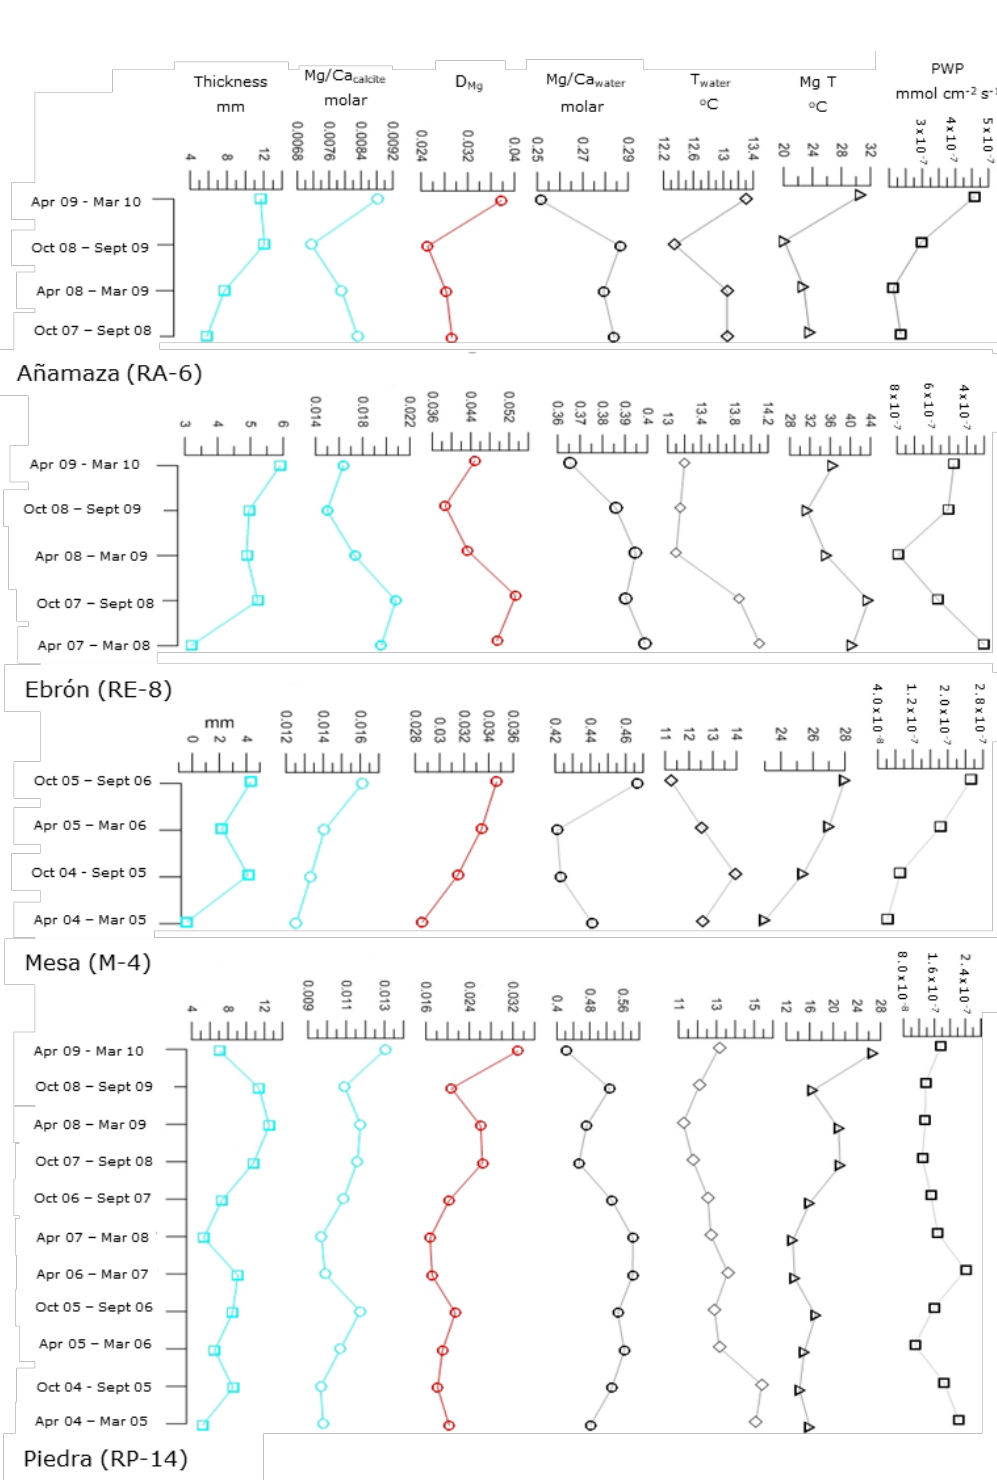
Figure 6. Temporal evolution of season-free interannual evolutions of some parameters during examined sampling periods in water and stromatolites for studied tablets. We present the six-month accumulated thicknesses, Mg/Ca calcite ratios, D Mg , Mg/Ca water ratios, measured water temperatures, Mg-derived water temperatures and stromatolite precipitation rates (as PWP values). We indicate the units in the figure.